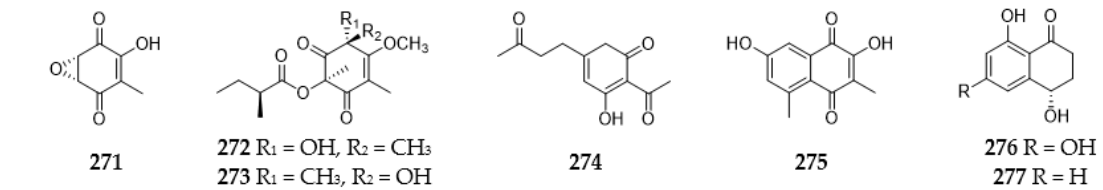
Figure 16. Aspergillus -derived benzoquinones ( 270 – 274) and naphthoquinones ( 275 – 277